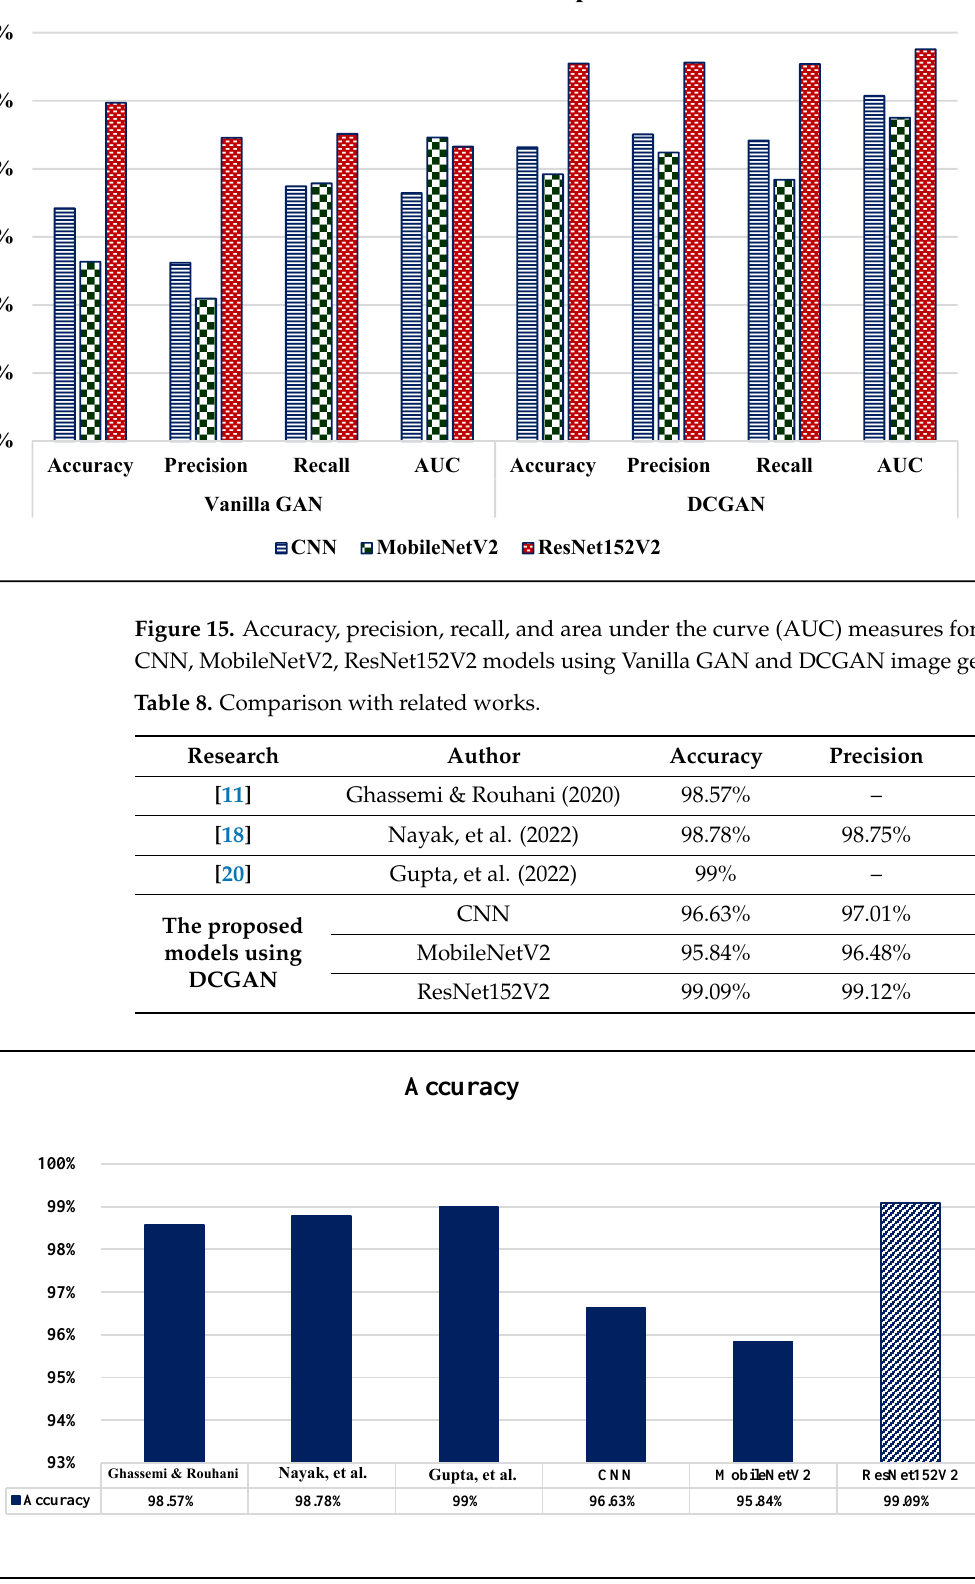
Figure 16. Accuracy performance metrics comparison between our proposed models and previous studies [11,18,20] .